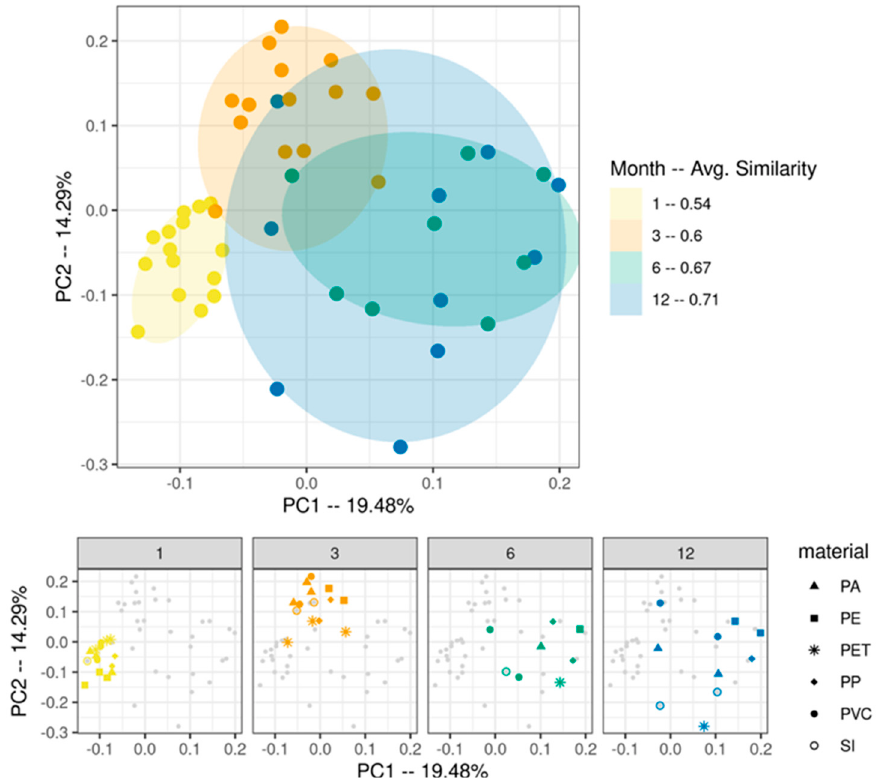
Figure 1. Principle coordinate analyses of 16S data based on Bray-Curtis dissimilarity matrix. The top plot shows the overall dataset, while the bottom plots give details on polymer types. PA: polyamide; PE: polyethylene; PET: polyethylene terephthalate; PP: polypropylene; PVC: polyvinyl chloride; SI: silica (control).